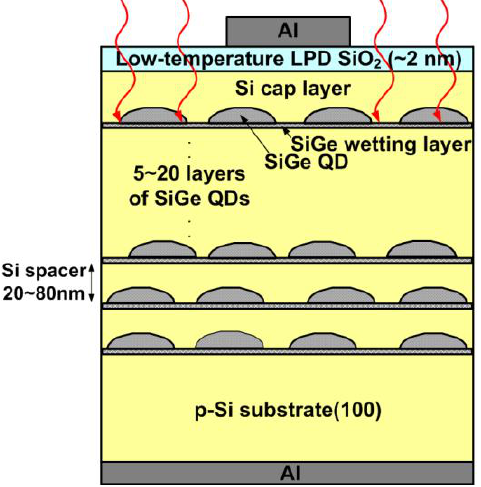
Figure 24. The schematic structure of MIS SiGe/Si QDIPs. The low-temperature LPD SiO layer was adopted in order to avoid the strain relaxation and interdiffusion between Si 2 and